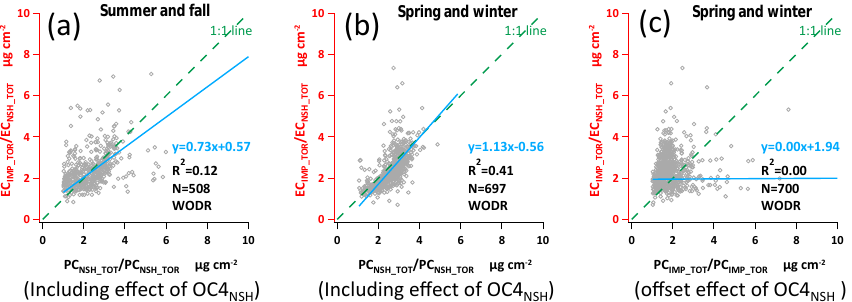
Figure 4. EC IMP_TOR -to-EC NSH_TOT discrepancy dependency on TOT/TOR charring correction. (a) EC IMP_TOR / EC NSH_TOT vs. PC NSH_TOT / PC NSH_TOR ratio–ratio plot for summer and fall. (b) EC IMP_TOR / EC NSH_TOT vs. PC NSH_TOT / PC NSH_TOR ratio–ratio / PC IMP_TOR ratio–ratio plot for spring and winter. plot for spring and winter. (c) EC IMP_TOR / EC NSH_TOT vs. PC IMP TOT